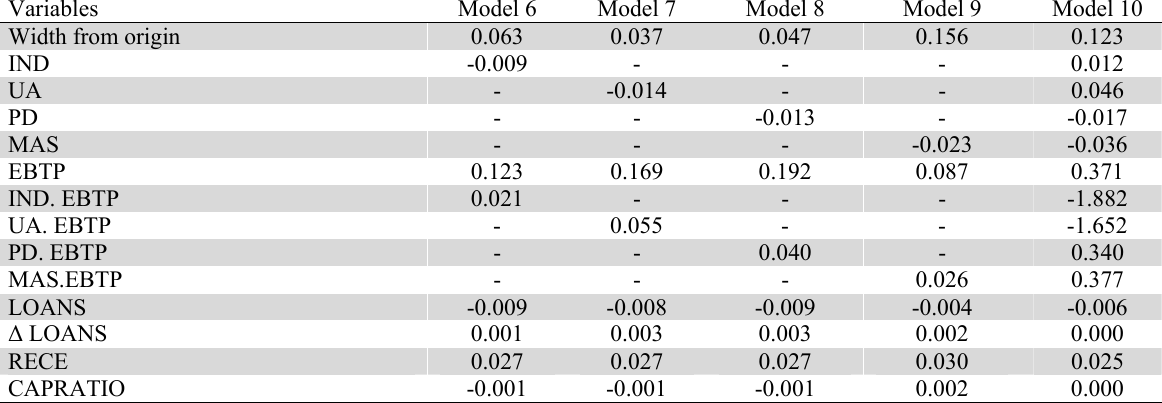
Table 3 Estimating relationship between LLP and independent variables (2005 - 2011)